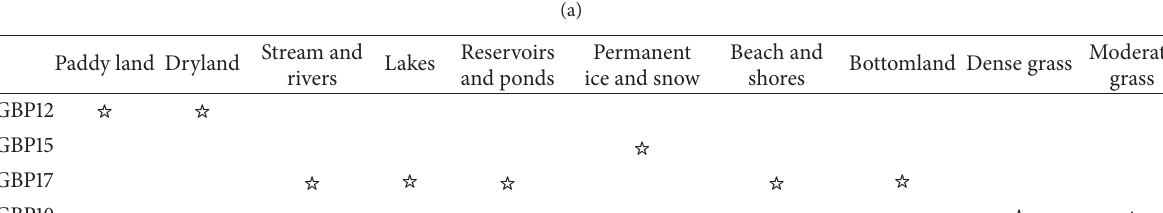
Table 2: Comparison between the CAS land use classification scheme and IGBP land cover classification scheme.